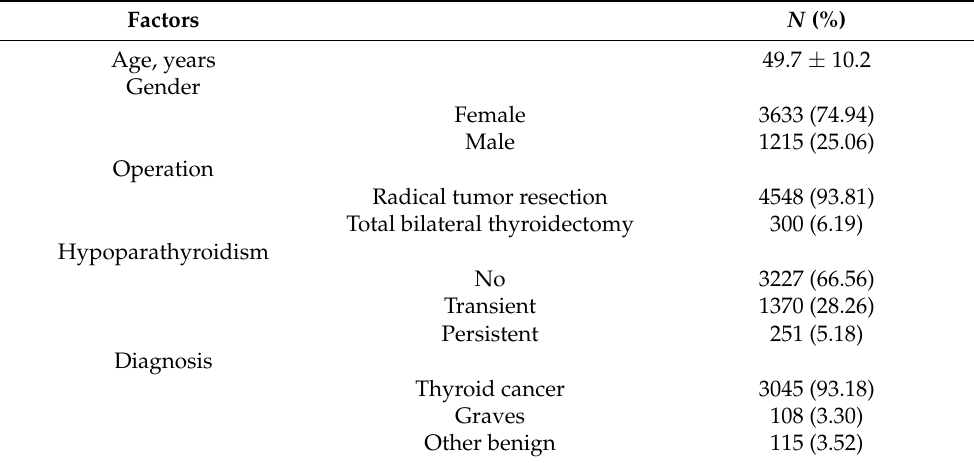
Table 1. Baseline Characteristics.